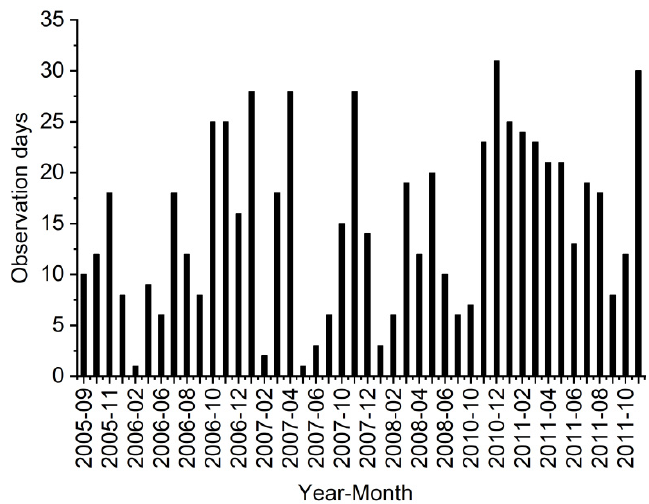
Figure 1. Distribution of observation days from September 2005 to November 2011.